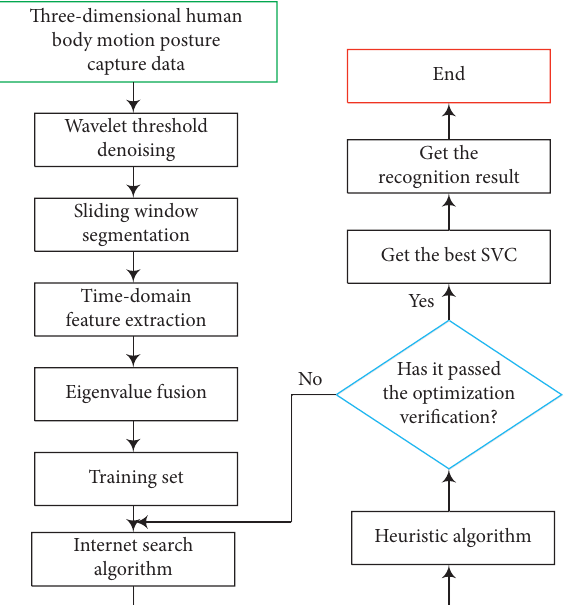
Figure 5: Flow chart of the experimental scheme of human upper limb movement